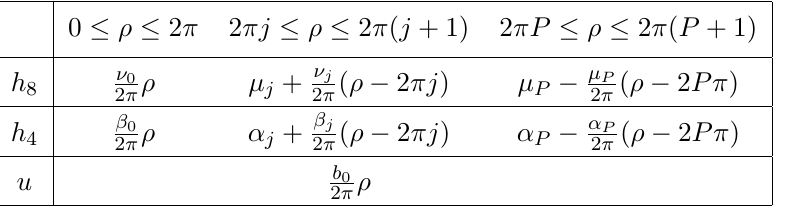
Table 1 . Piece-wise continuous functions satisfying the conditions in eq. (2.5). The value of u ( ρ ) is the same in all intervals, as required by